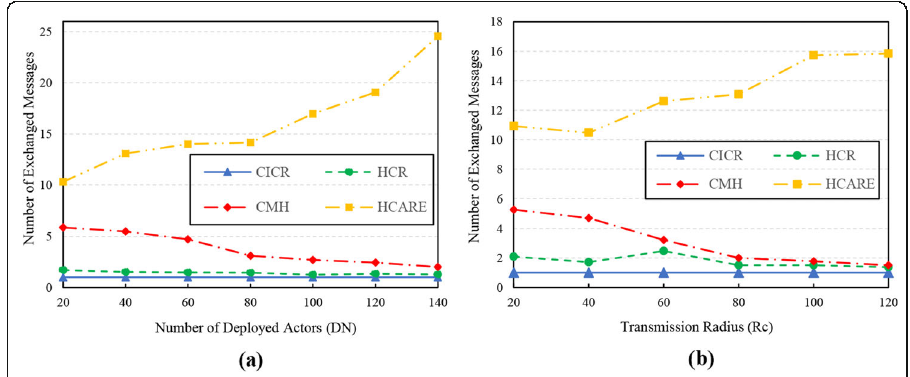
Fig. 8 The number of exchanged messages with varying ( a ) the number of actors (fixed R c = 80), ( b ) the transmission radius (fixed DN =